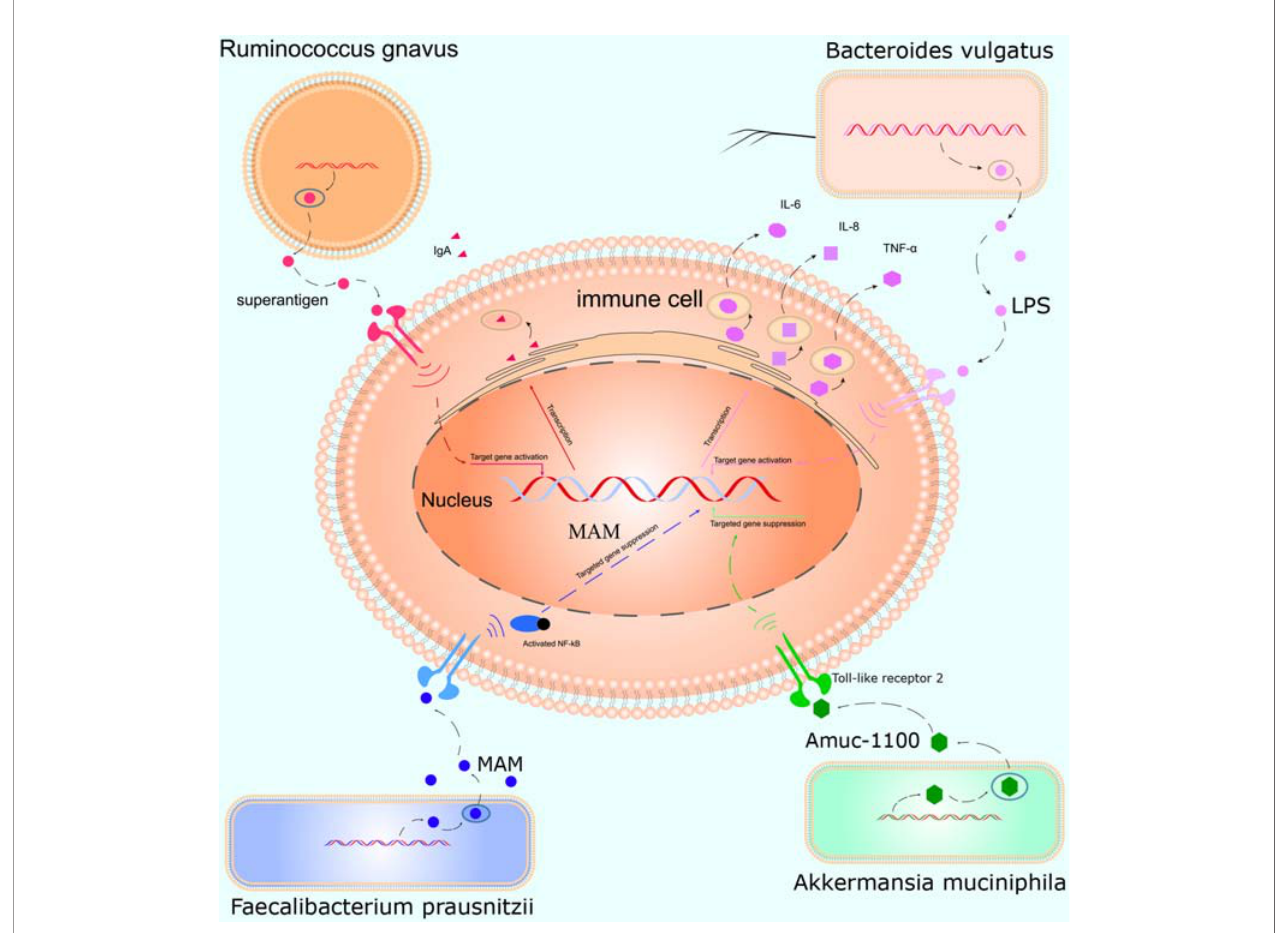
FIGURE 5 | Mechanism of action of the gut microbiota in in fl ammation. Ruminococcus gnavus contains speci fi c genes that encode superantigens to induce and bind IgA antibody in vivo . Bacteroides vulgatus produces LPS, which activates T cells and promotes immune cells to produce cytokines such as IL-6, IL-8, and TNF- a . Faecalibacterium prausnitzii inhibits in fl ammation by producing MAM to inhibit NF- k B activation in the intestinal microbiome. Akkermansia muciniphila secretes the peptide, Amuc_1100, which interacts with Toll-like receptor 2, improves the gut barrier and decreases in fl